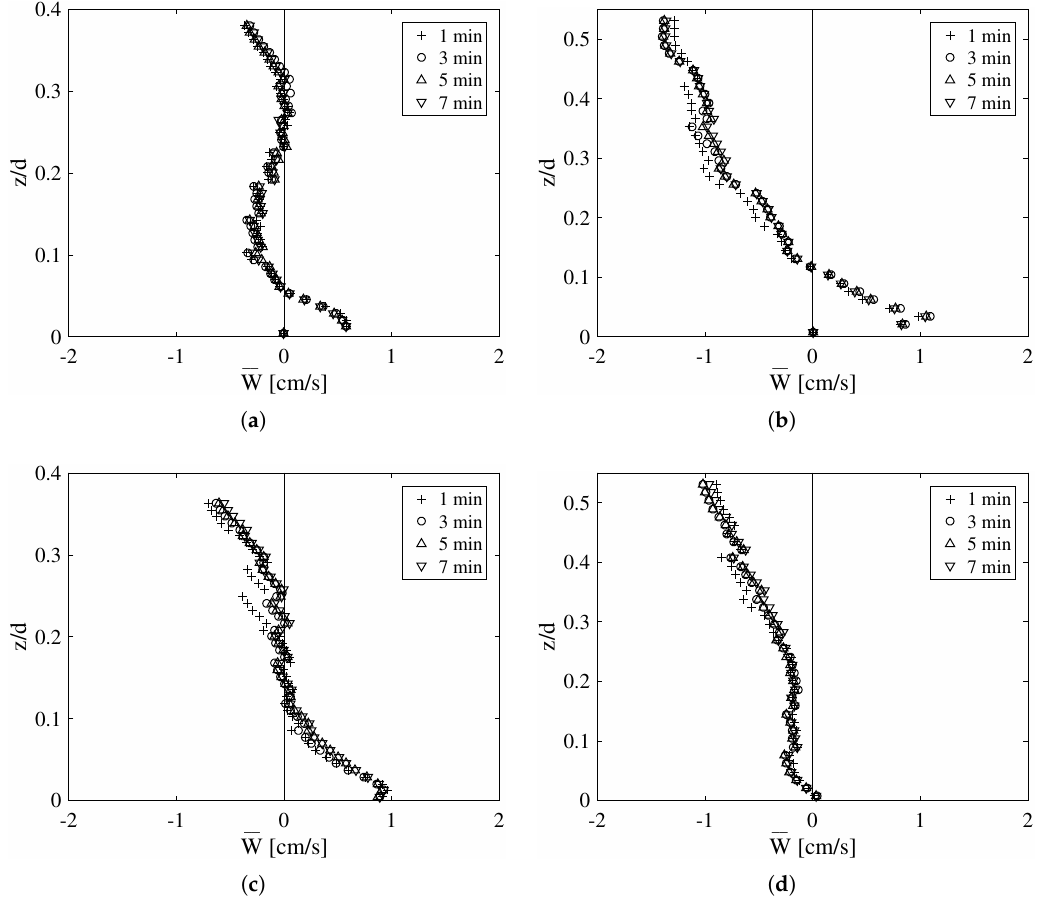
Figure 5. T 9 test ( H = 5.86 m, T = 1.26 s), period averaged W velocity profiles in the z direction evaluated on the basis of measurement with durations ranging from 1 to 7 min: ( a ) P 1 , L 2 ; ( b ) P 2 , L 2 ; ( c ) P 1 , L 8 ; and ( b ) P 2 , L 8 (see Figure